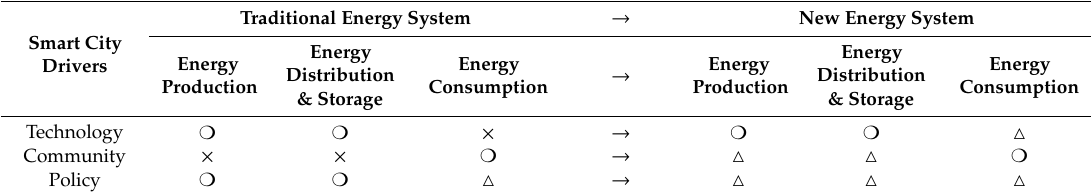
Table 1. Comparison of smart city drivers’ contribution to the energy